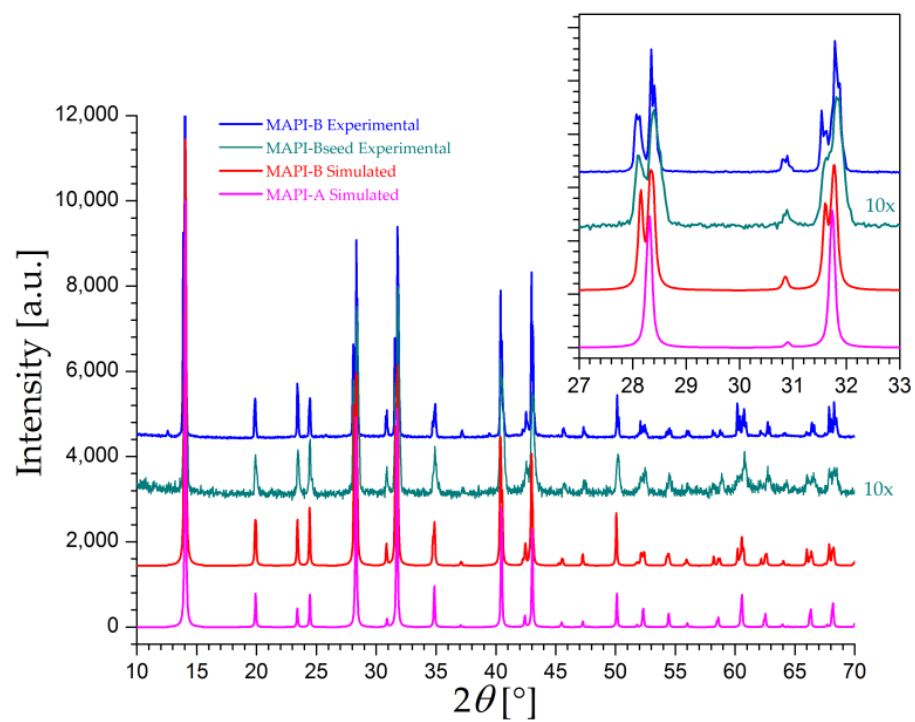
Figure 5. Experimental X-ray powder diffraction (XRPD) patterns for sample (blue) and sample B seed (cyan), its intensity was magnified 10×, and calculated XRD patterns of crystal B (red) and crystal A (magenta) based on structural refinement. The XRPD patterns of MAPI grown in formic acid are in agreement with the orthorhombic Fmmm symmetry.